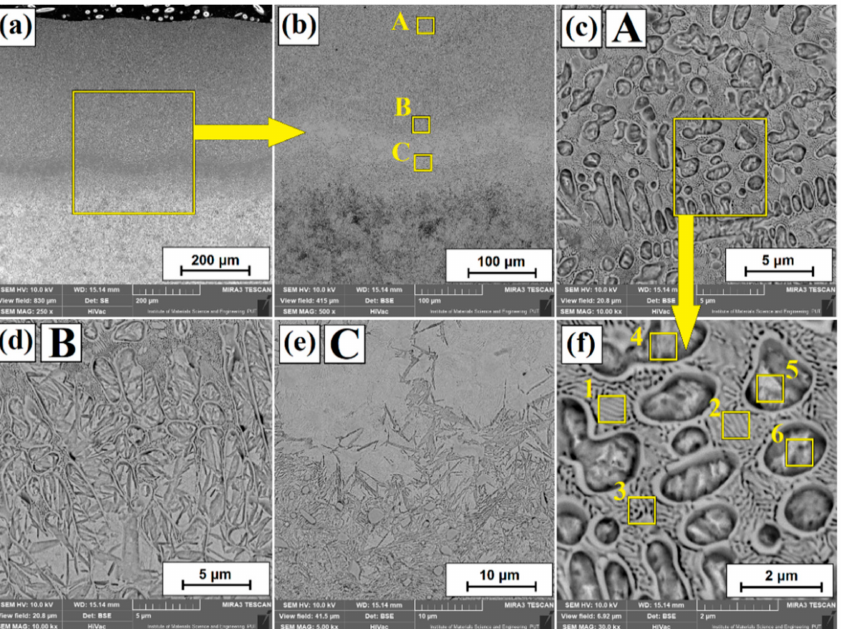
Figure 4. Microstructure of B-Cr coatings obtained using laser processing by laser beam power of 900 W: laser tracks ( a ), enlarging the laser track ( b ), upper area of remelted zone ( c ), boundary between the remelted zone and the heat-affected zone ( d ), heat-affected zone ( e ), and enlarging of upper area of remelted zone ( f ).